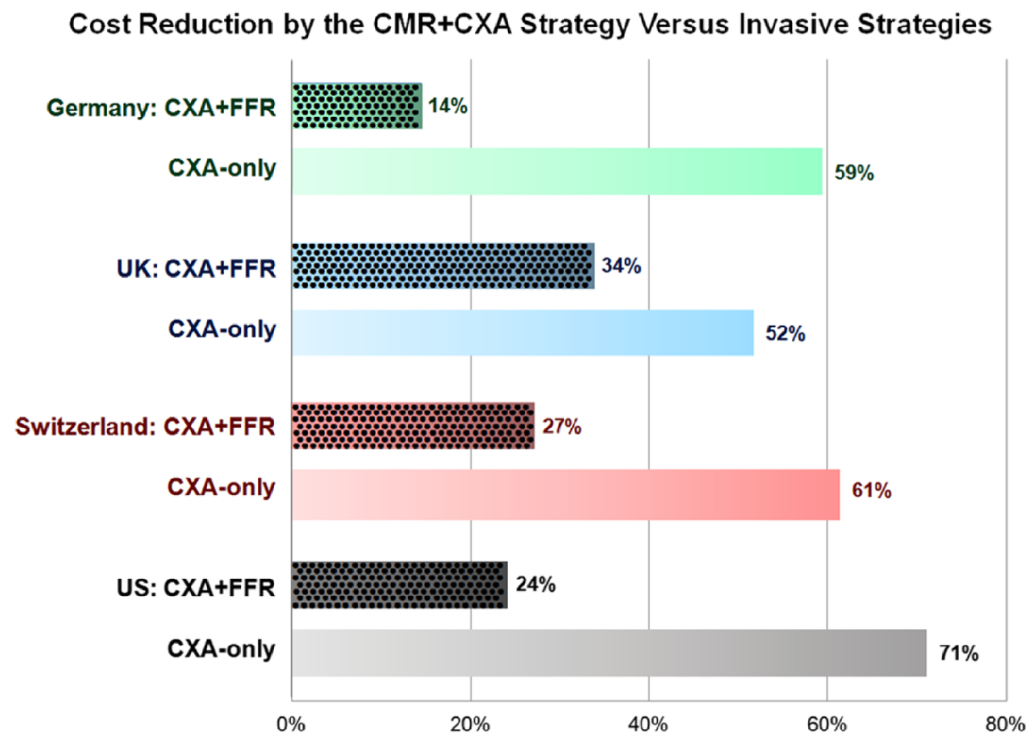
Figure 2. Percentage of cost reductions of the cardiac magnetic resonance (CMR)–X-ray coronary angiography (CXA) strategy vs. CXA + fractional flow reserve (FFR) and CXA-only strategy in patients with suspected coronary artery disease (CAD) analyzed for different healthcare systems (Germany, United Kingdom [UK], Switzerland, and United States [US]). CMR can help to minimize costs for the health system. Adapted from 36 with permission